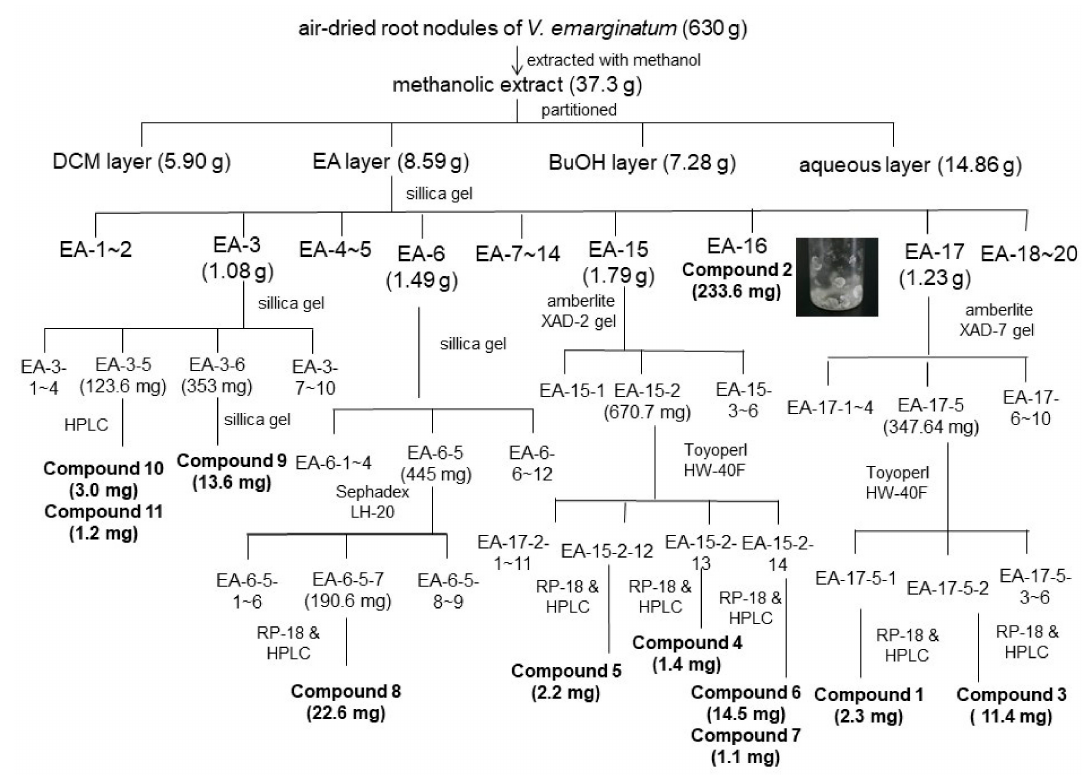
Figure 4. Purification flow chart of chemical constituents isolated from root nodules of V.